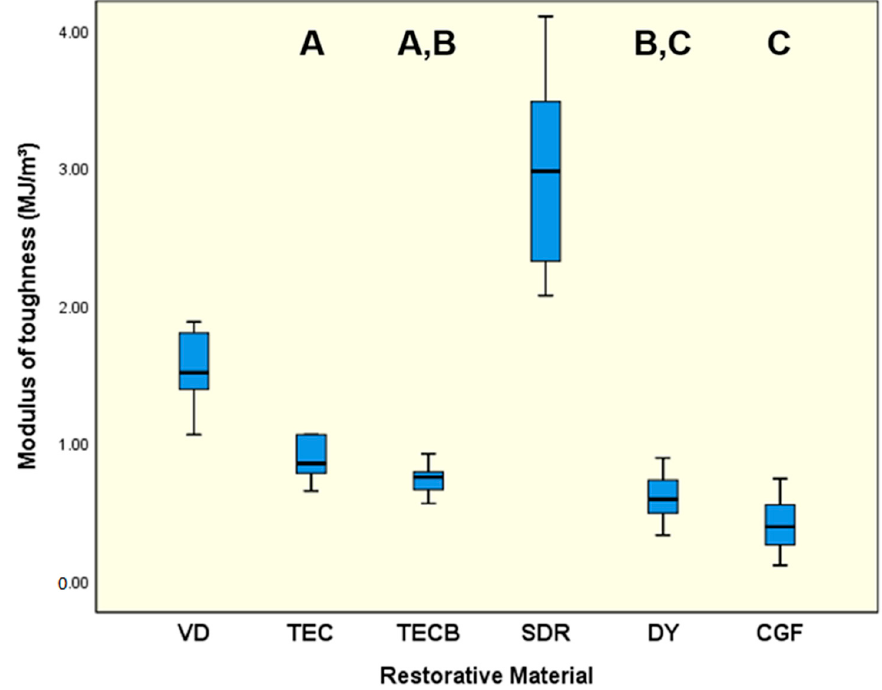
Figure 4. Modulus of toughness (MJ/m 3 ). Identical uppercase letters denote no significant difference among calculated means of restorative materials ( p > 0.05) while different uppercase letters represent significant differences ( p < 0.05).